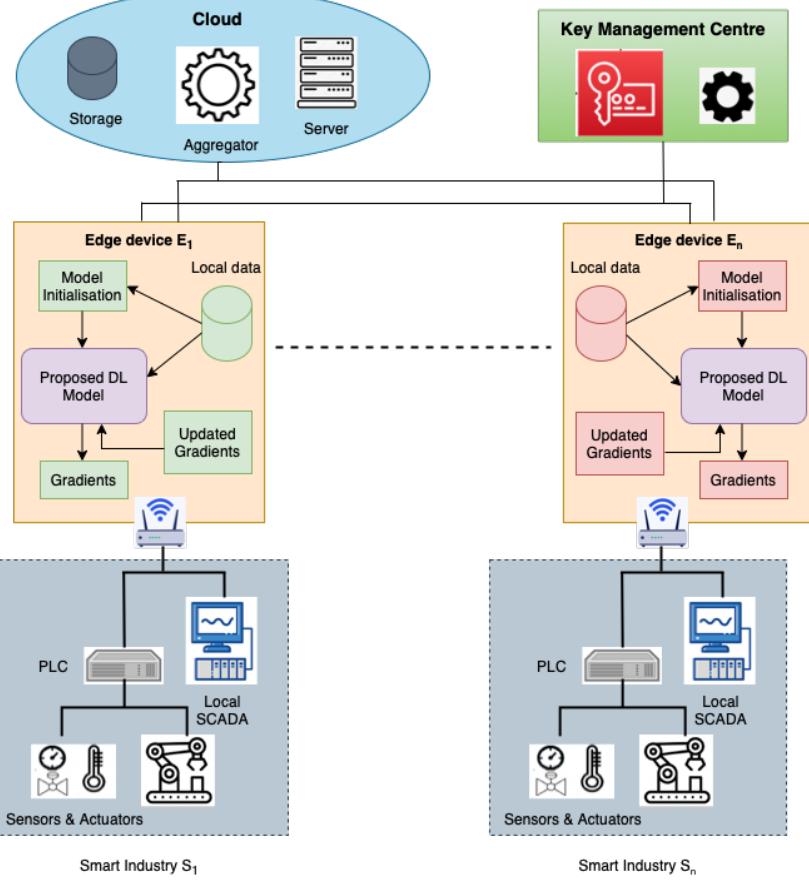
Figure 1. System architecture for proposed